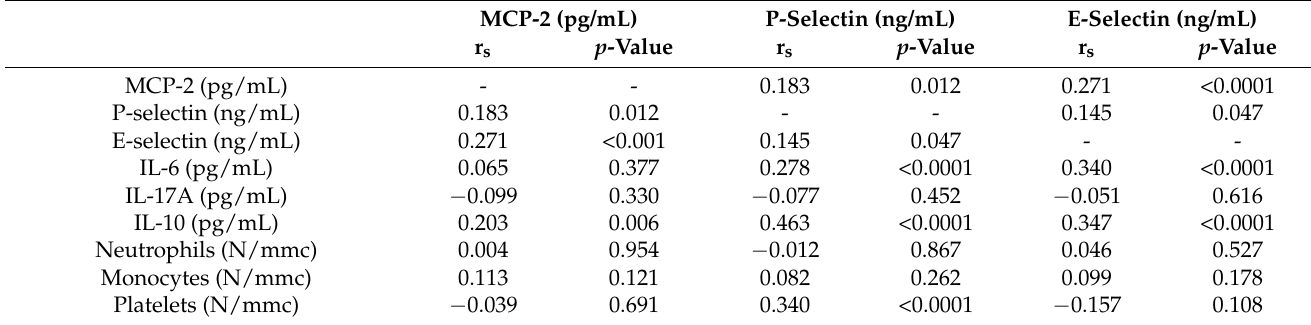
Table 3. Correlations among serum MCP-2, selectins, inflammation parameters, blood cell, and platelet number at